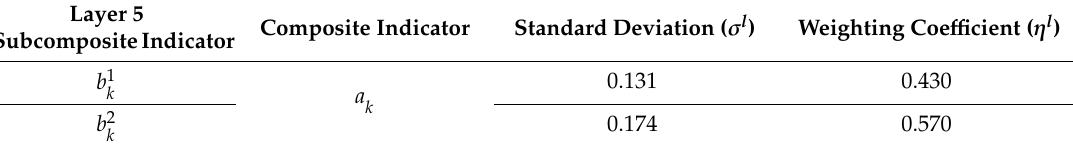
Table 5. Weighting coe ffi cients for calculation of the composite index